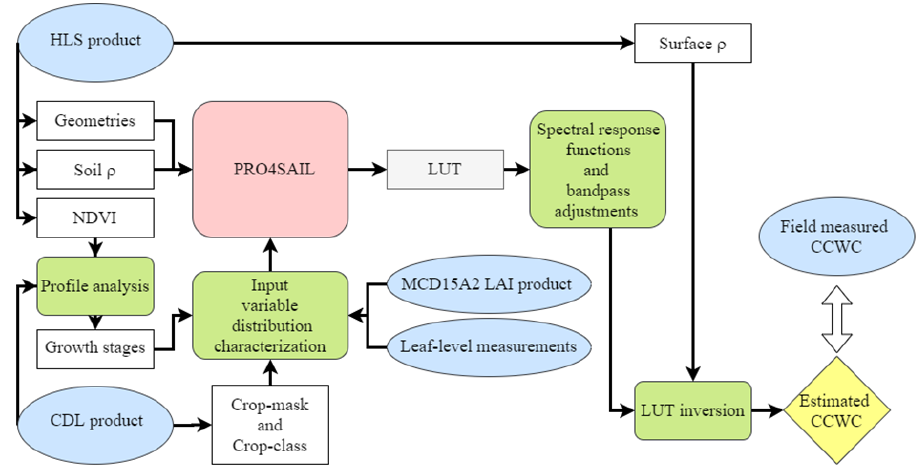
Figure 5. Conceptual diagram of PRO4SAIL inversion optimization using a priori information and HLS product. Input datasets are presented in the blue ovals while processing steps and intermediate data are presented in the green and white rectangles, respectively. Finally, the final cropland canopy water content (CCWC) output is presented in the yellow diamond.